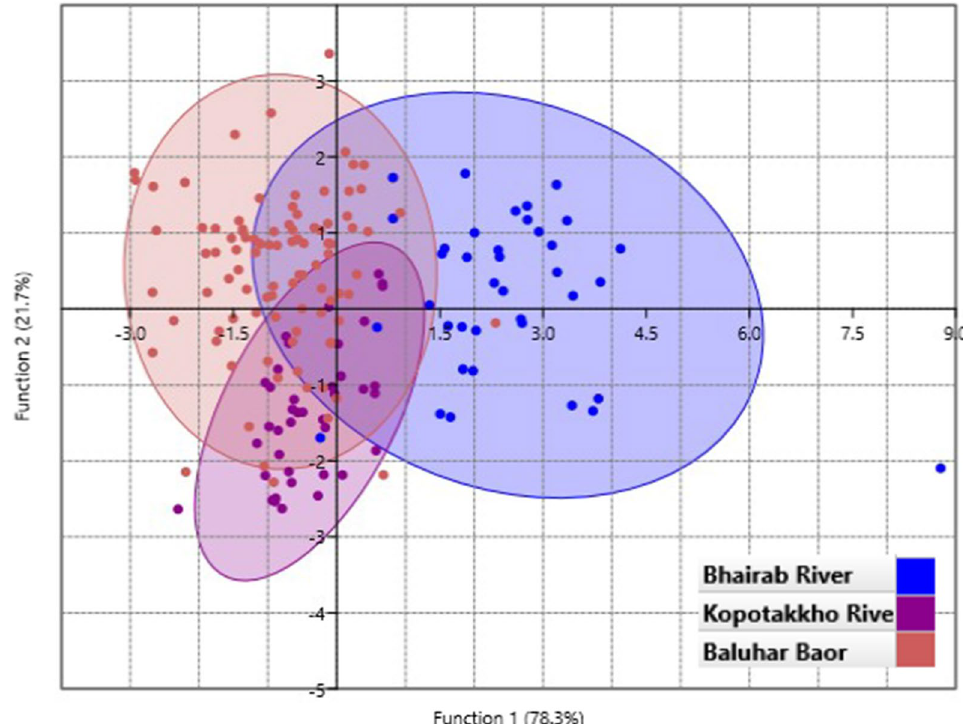
Fig. 6 Discriminate function analysis based biplot from conventional and truss measurements H. limbatus collected from three different habitats in Southwestern Bangladesh